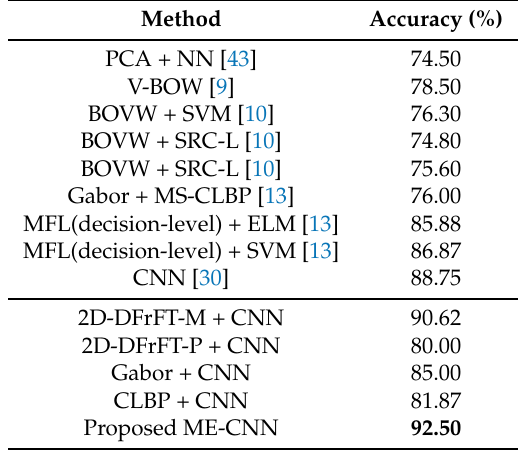
Table 6. Comparison of classification accuracy (%) with some state-of-the-art methods for the original BCCT200 data.